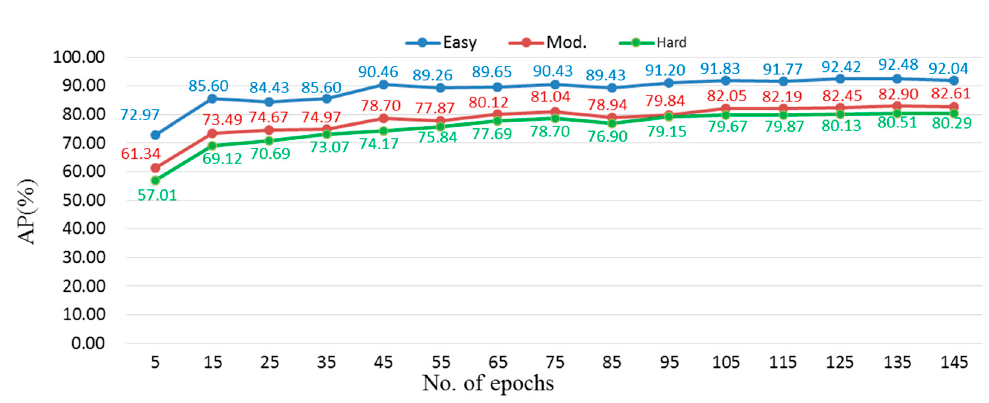
Figure 4. The AP values for different training epoch numbers.